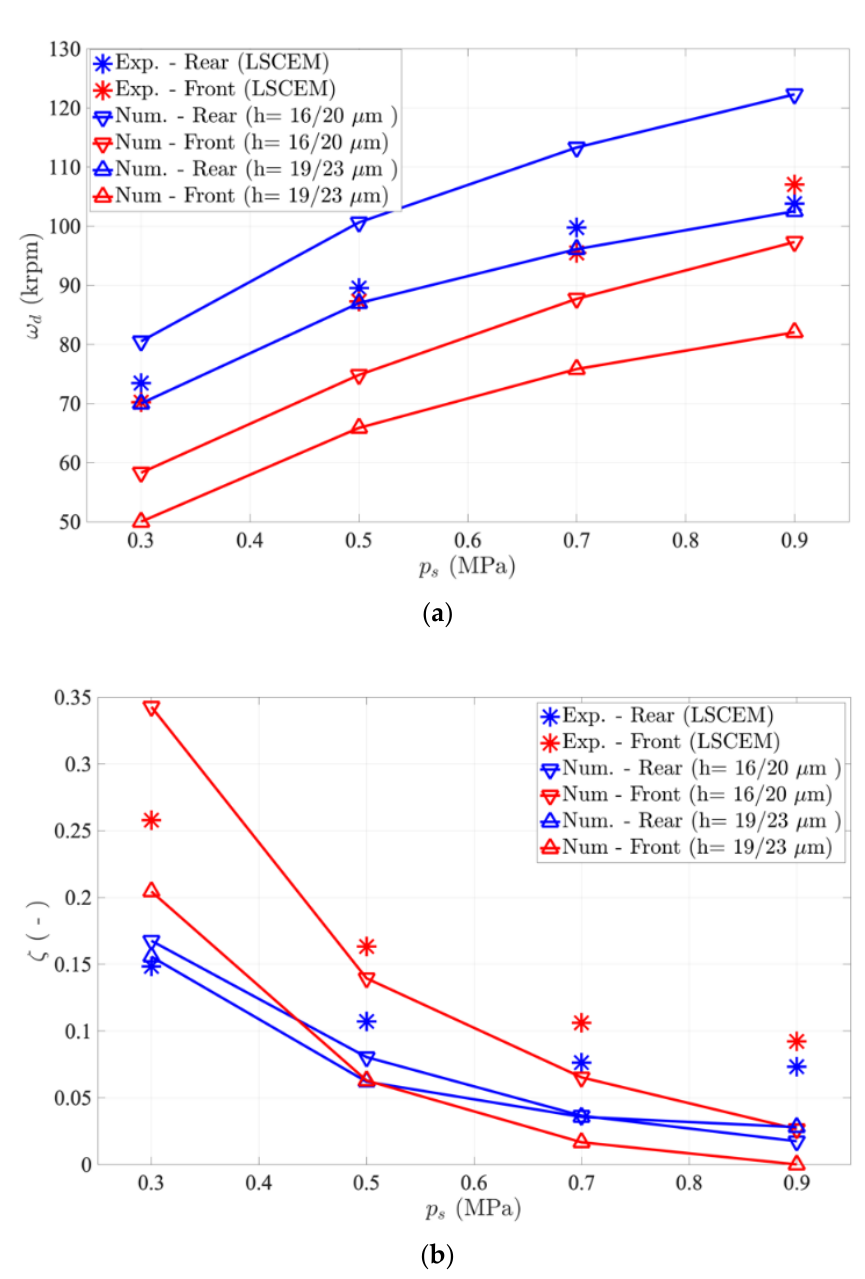
Figure 16. Comparison of experimental and numerical damped frequencies ( a ) and damping factors ( b ) on rear plane.